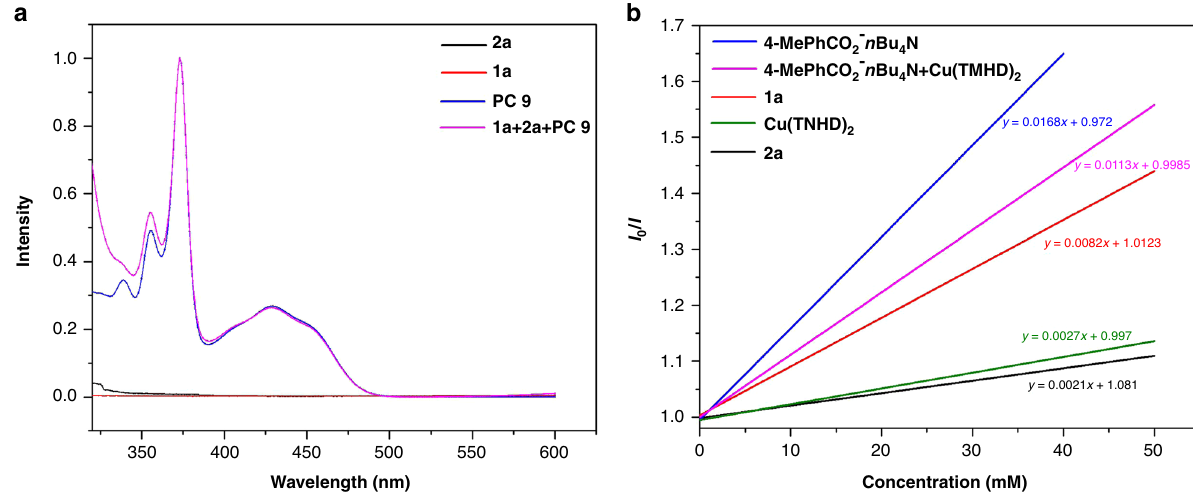
Fig. 6 UV – vis absorption and fl uorescence quenching experiments. a UV – vis absorption spectra of 1a , 2a , PC 9 , and the reaction mixture. b Emission- quenching experiments of the anion of 2a (4-MePhCO 2 − n Bu 4 N + ), 2a , 1a , Cu(TMHD) 2 , and the anion of 2a with Cu(TMHD) 2